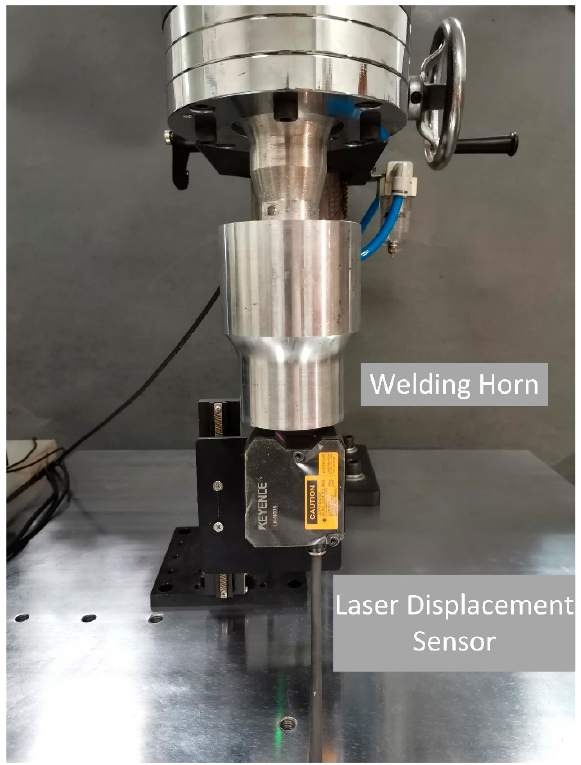
Figure 15. Experimental setup of vibration control verification.